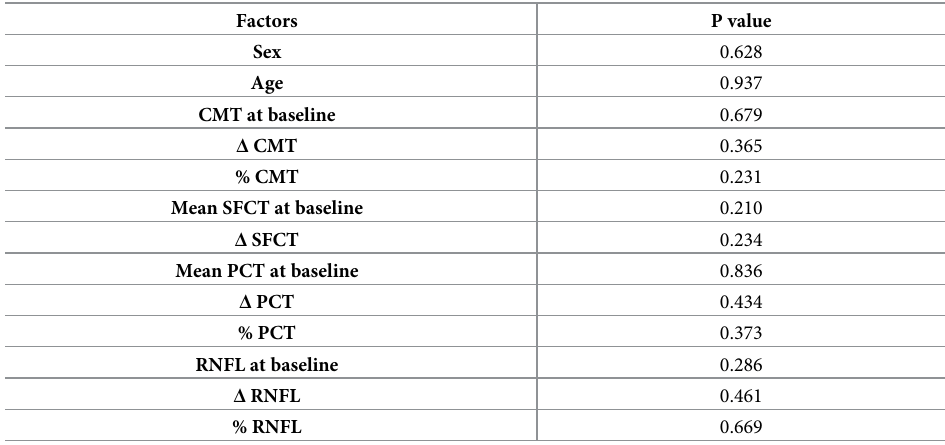
Table 3. Possible predictive factors for visual outcome at 12 months in the eyes with central retinal vein occlusion.